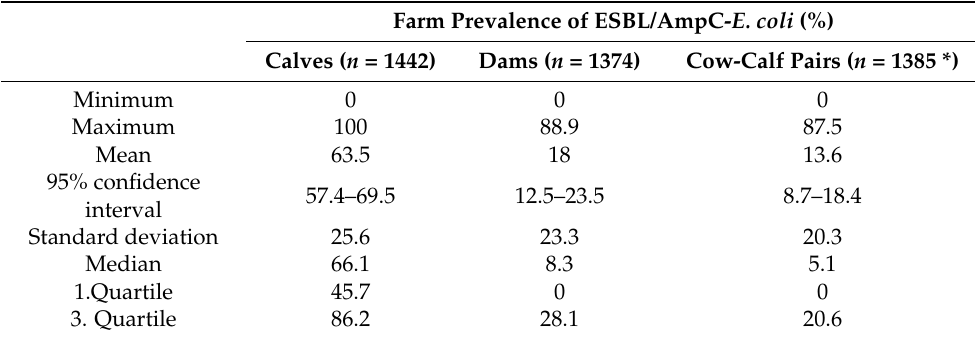
Table 1. Farm prevalence of ESBL/AmpC- E. coli in calves, their dams and cow-calf pairs. Farm Prevalence of ESBL/AmpC- E. coli (%) Calves ( n = 1442) Dams ( n = 1374) Cow-Calf Pairs ( n = 1385 *) Minimum 0 0 0 Maximum 100 88.9